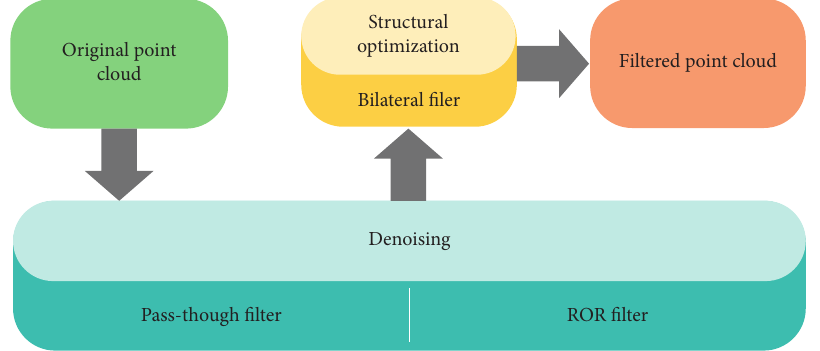
Figure 5: Flow chart of point cloud filter.